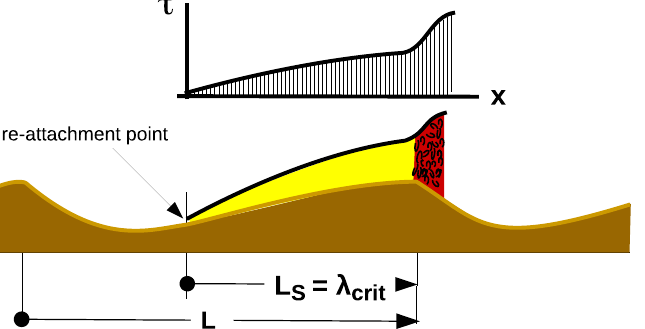
Figure 6. Principle sketch of the development of a ripple starting from initial disturbances on a flat bed. The stoss-side develops from a flat bed in a feedback process with the boundary layer. Sediment is retained and, at the same time, the local shear stress increases until transport is balanced at each